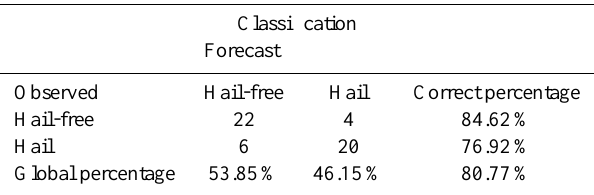
Table 9. Contingency table for verification of HDT by cumulonim- bus events in summer 2011.